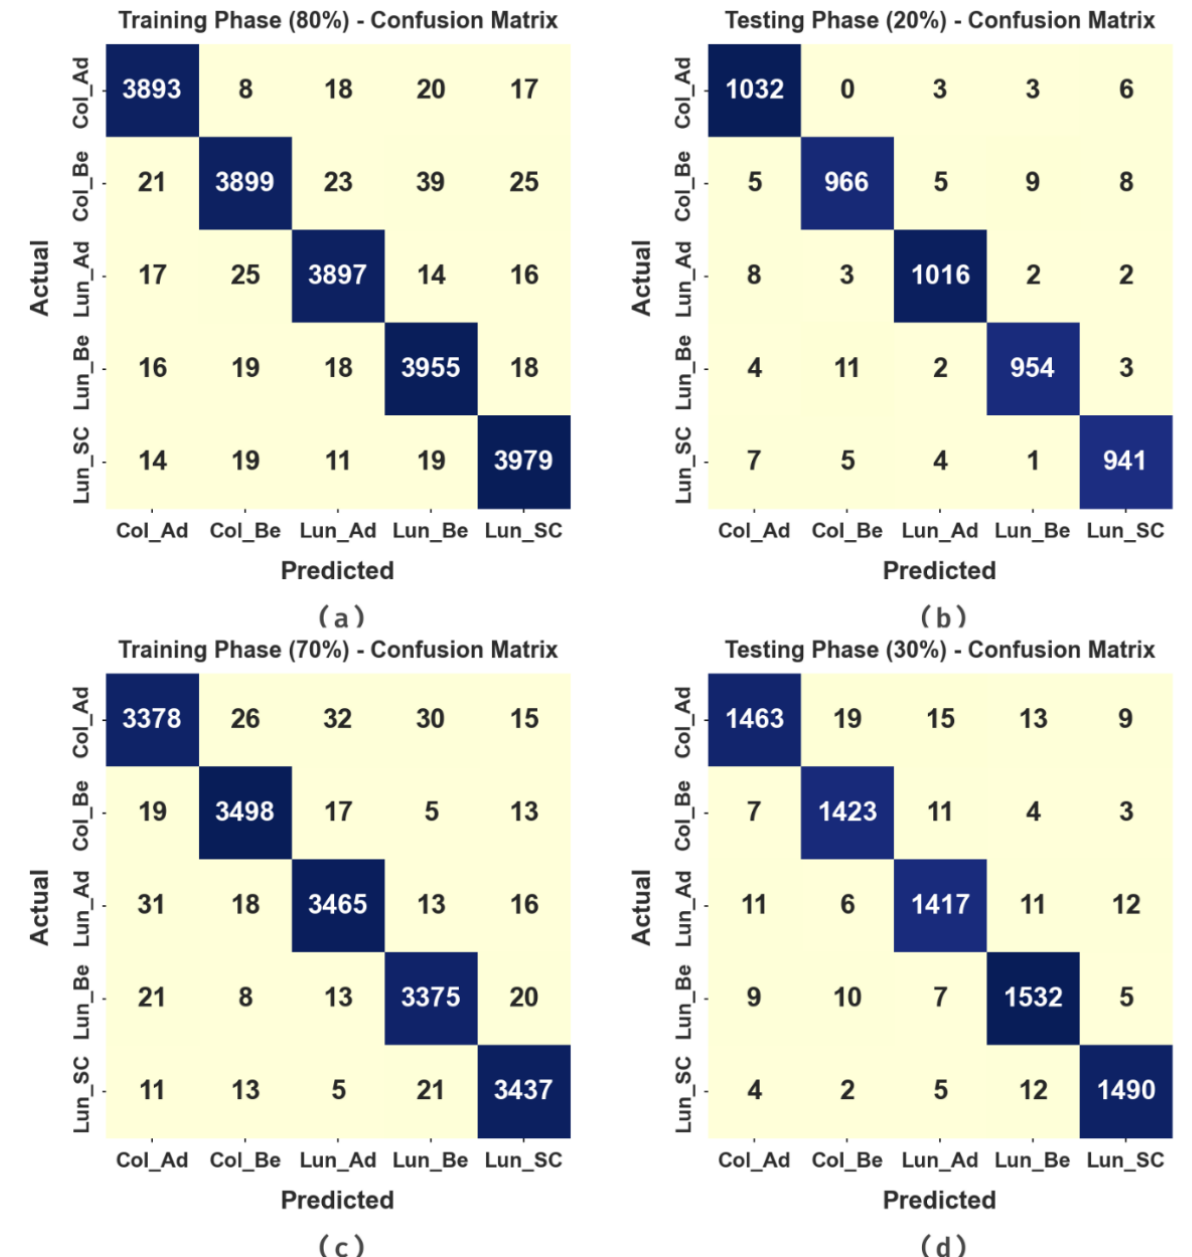
Figure 4. Confusion matrices of MPADL-LC3 approach: ( a , b ) TRS/TSS of 80:20 and ( c , d ) TRS/TSS of 70:30. Table 2. Classifier outcomes of MPADL-LC3 approach on TRS/TSS of